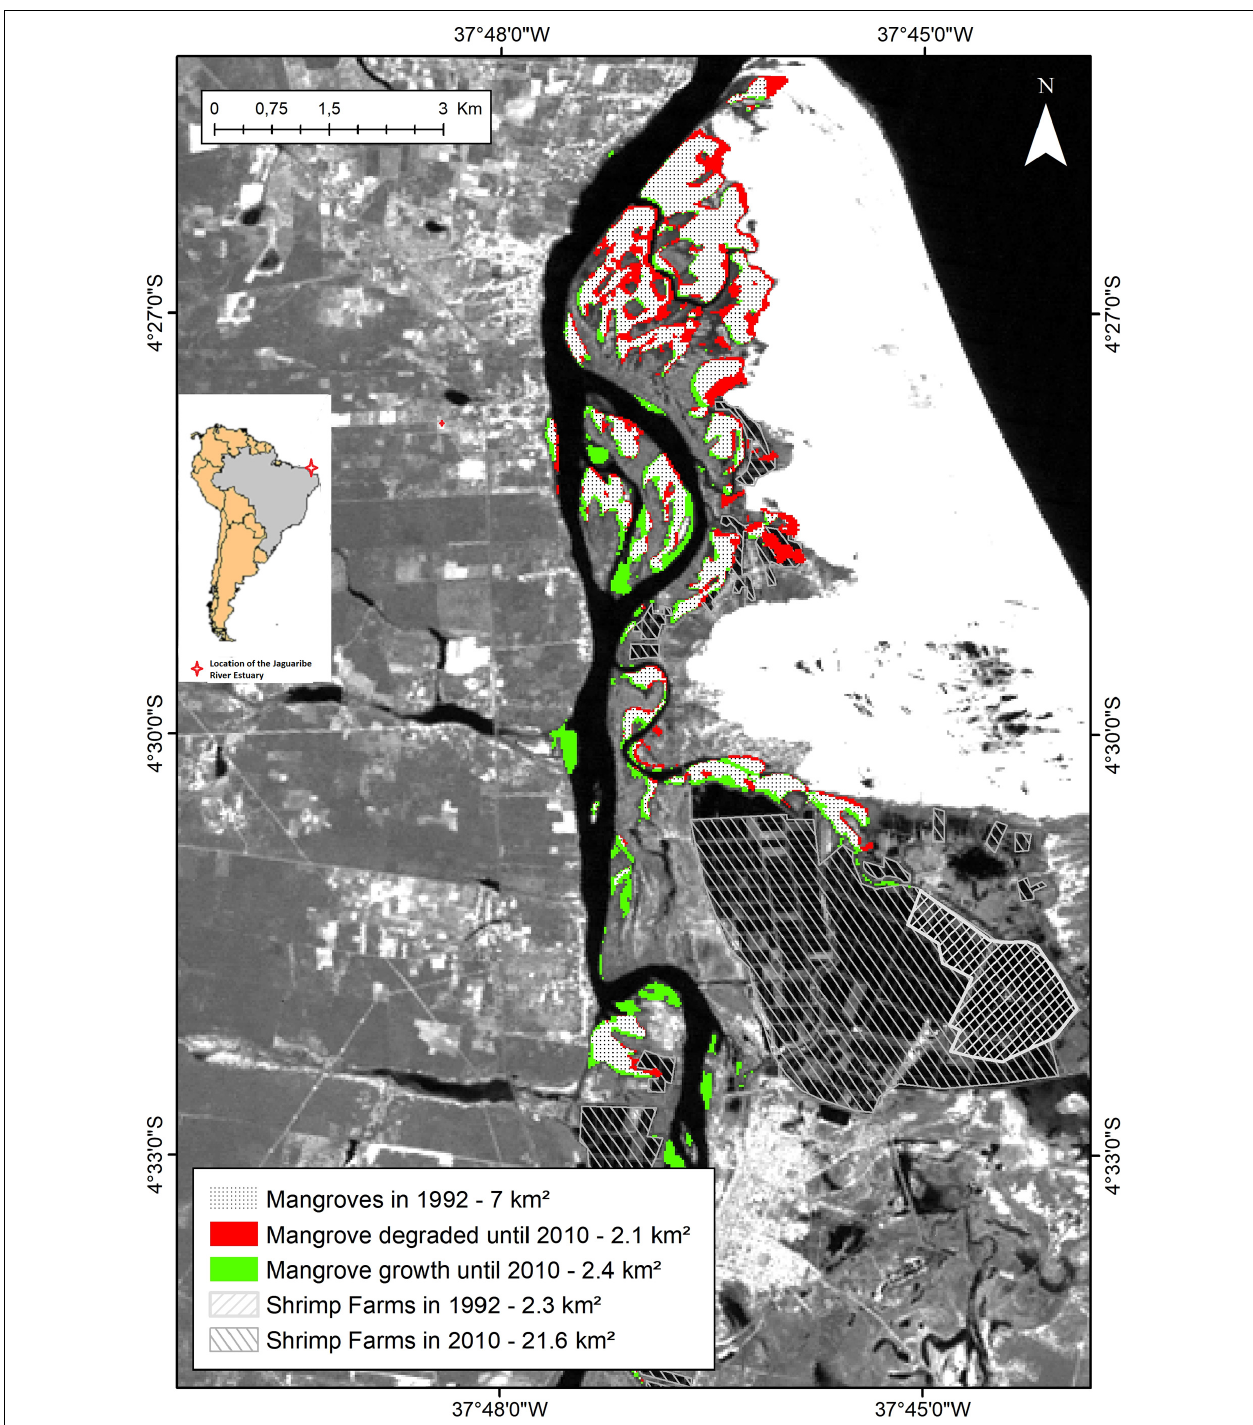
FIGURE 2 | Evolution of mangrove and shrimp farm areas in the Jaguaribe River estuary, the largest concentration of aquaculture activities in Brazil, between 1992 and 2010, when most expansion of the activity occurred.